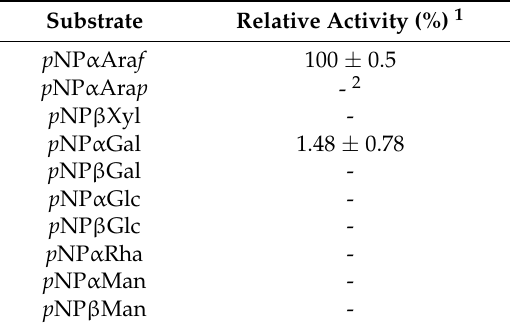
Table 4. Hydrolytic activity of Pp Abf51b on different p-nitrophenyl linked glycosides.